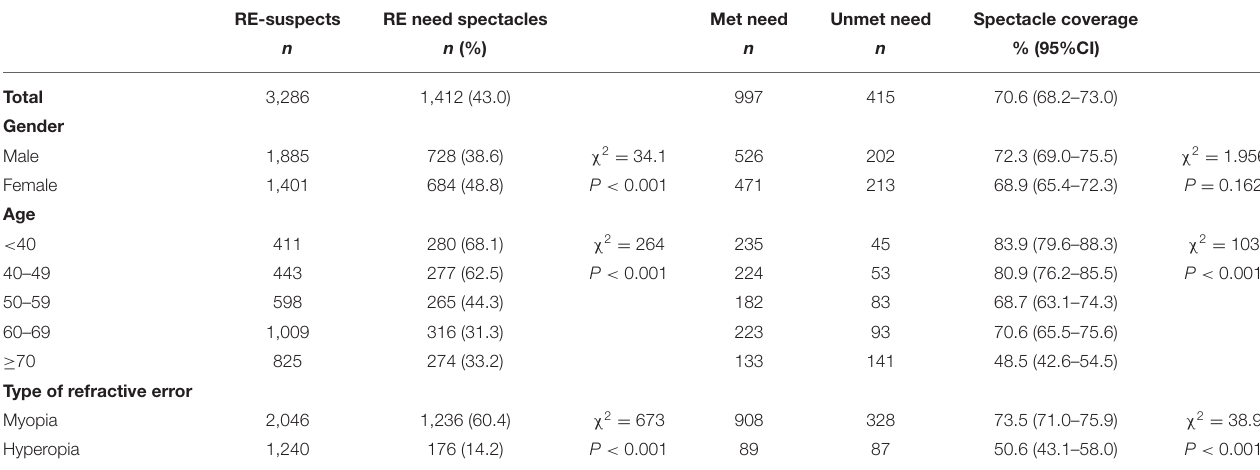
TABLE 3 | Spectacle need and coverage by the gender, age, and type of